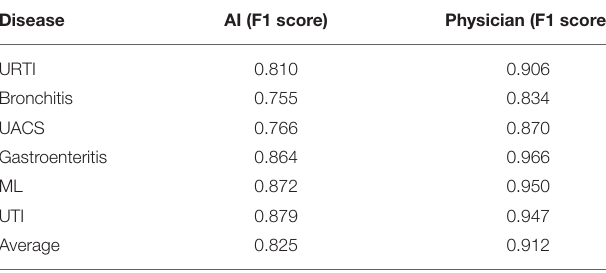
TABLE 1 | Diagnostic performance of the AI model and the physician for the dataset one ( n = 1,573). Disease